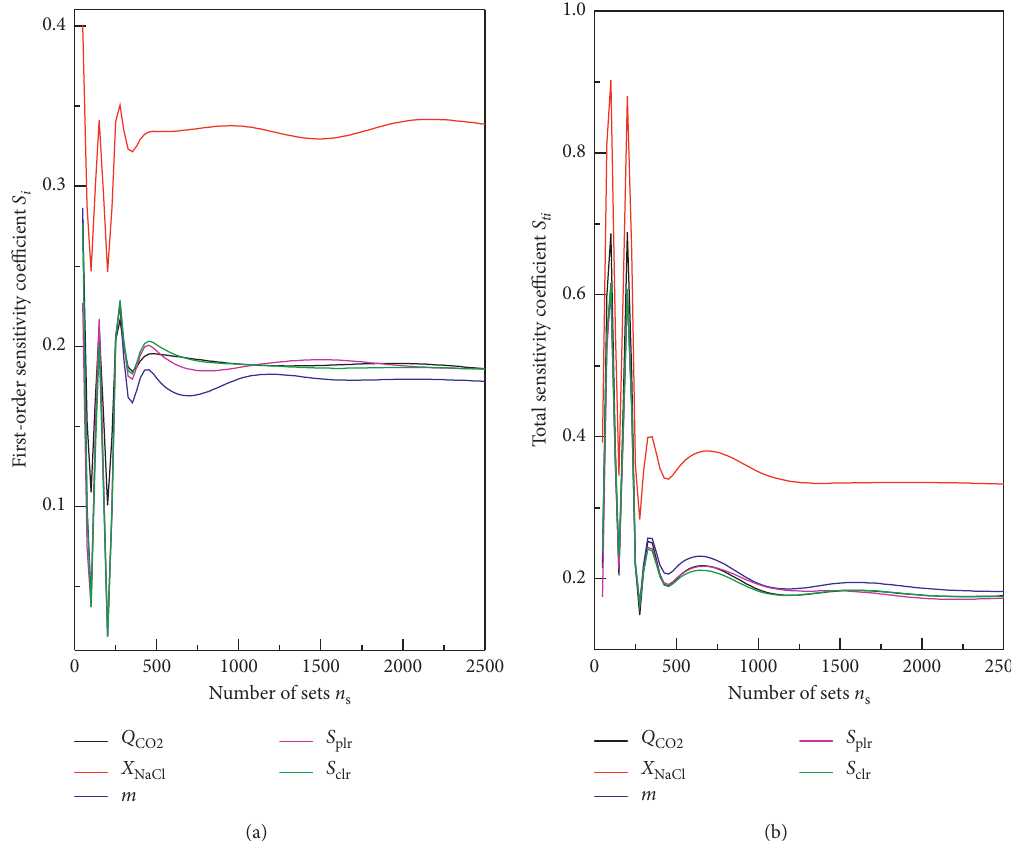
Figure 5: (a) S i and (b) S ti as functions of sets ( n s ) using the Sobol